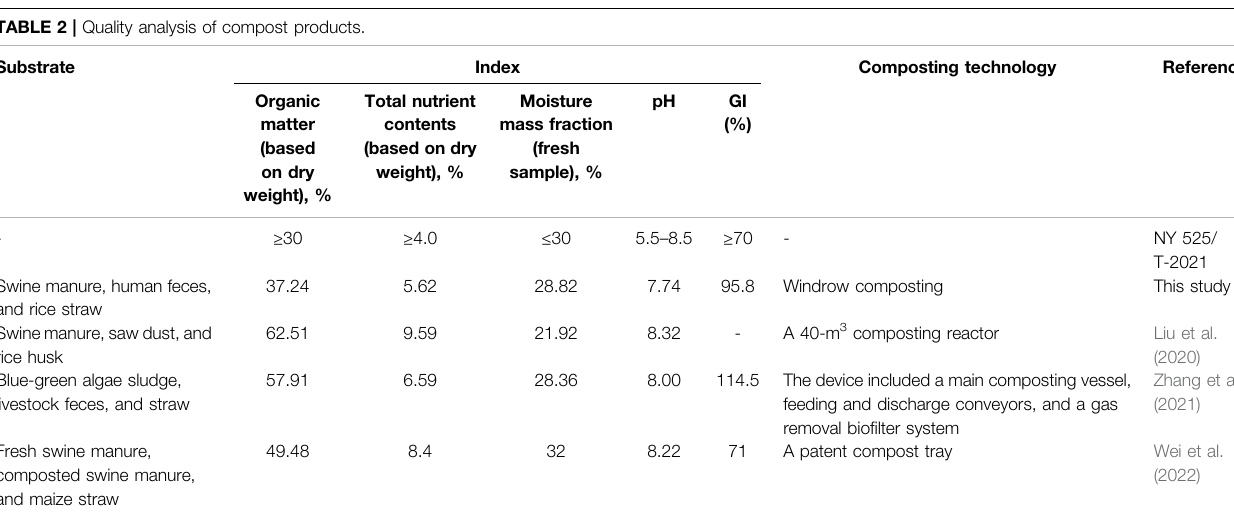
TABLE 2 | Quality analysis of compost